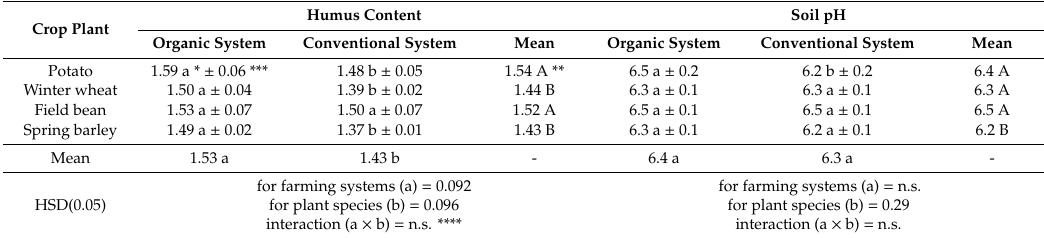
Table 8. Soil humus content (in %) and soil pH (in 1 M KCl dm − 3 ) in the 0–25 cm soil layer. Crop Plant